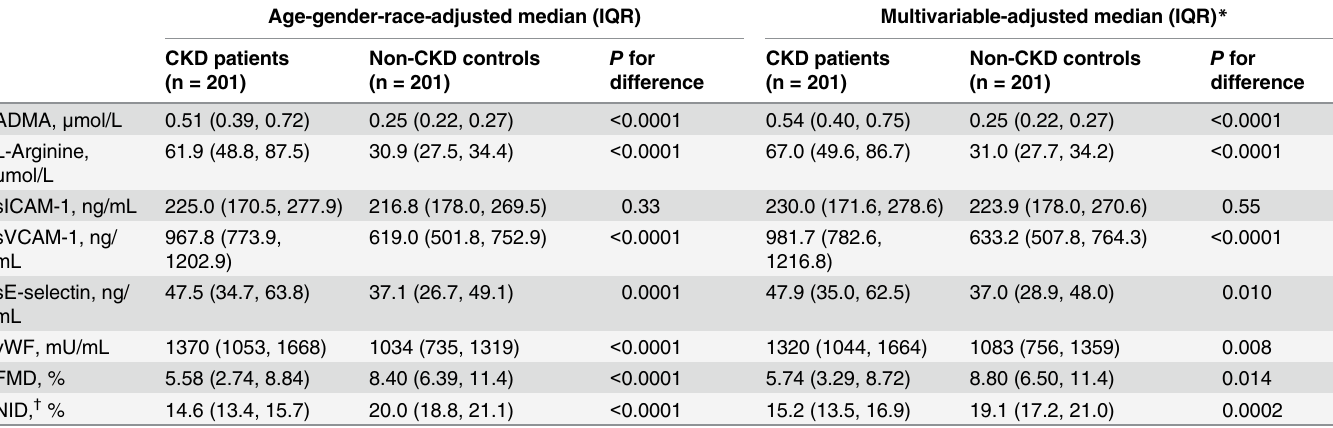
Table 2. Biomarkers of Endothelial Dysfunction According to Chronic Kidney Disease